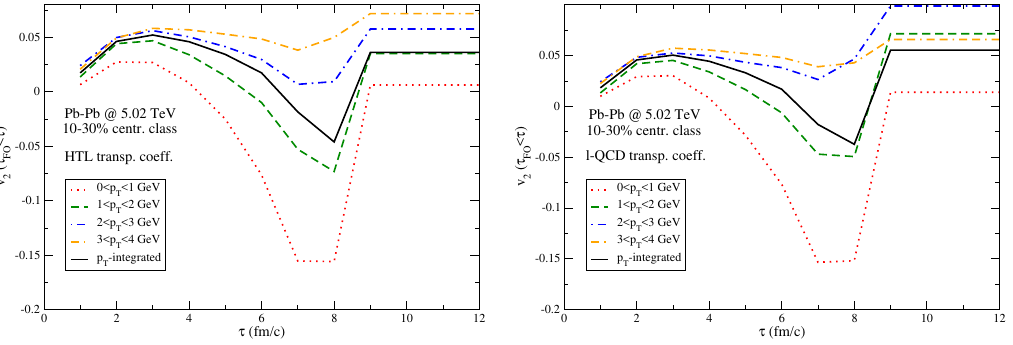
Figure 7 . Time development of the elliptic (cid:13)ow in 10-30% semi-central Pb-Pb collisions arising from the sum of the contribution of all charm quarks having decoupled from (cid:28) 0 up to time (cid:28) . Results obtained with HTL (left panel) and l-QCD (right panel) transport coe(cid:14)cients are displayed.